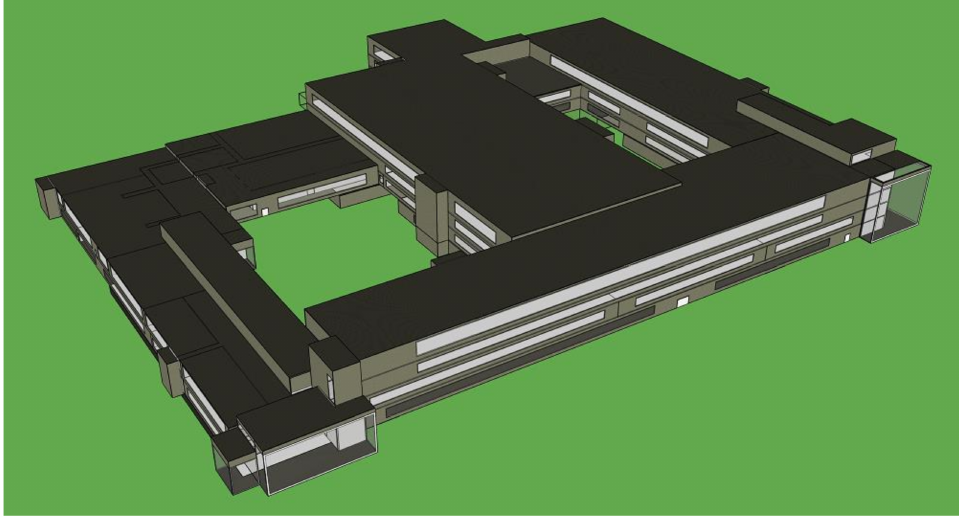
Figure 1. Dynamic campus building energy model constructed in IDA ICE. Walls, roofs, doors, and windows are visible in the three-dimensional representation. The long facade in the forefront is facing